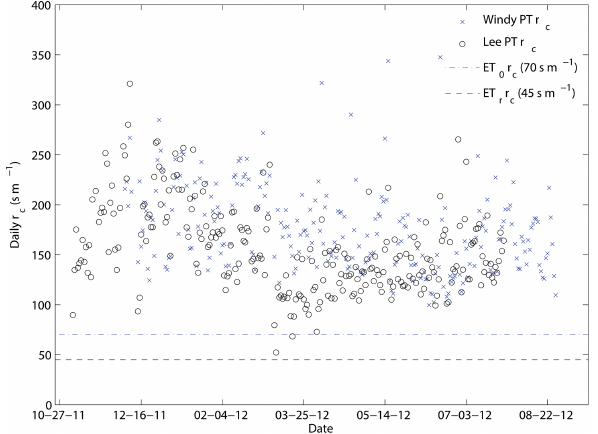
Figure 8. Calculated daily bulk canopy resistances at Windy and Lee from inverting the Priestley–Taylor (PT) ET for the mid-period. Dotted lines again show daily time step resistances from short and tall canopy for